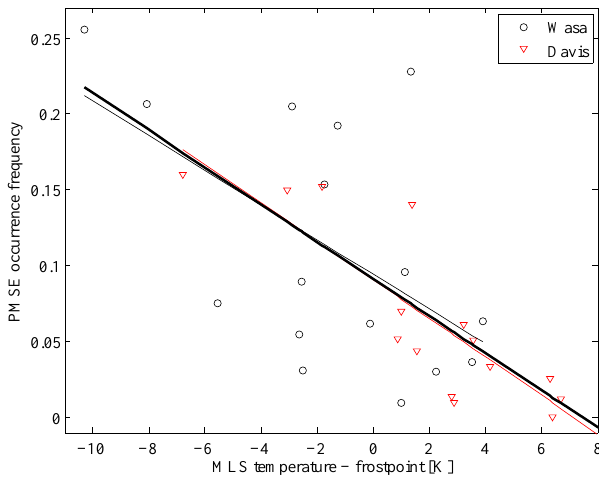
Fig. 5. The standard deviation of the occurrence frequency in the altitude interval 82 - 88 km as a function of local solar time. Data from MARA Wasa are shown with a black line, data from Davis with a red line. Thick vertical bars indicate 19 magnetic local time at Wasa (black) and at Davis (red).